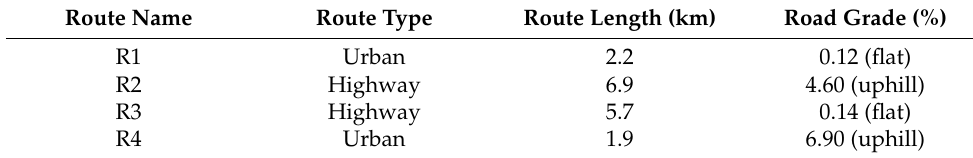
Table 3. Test routes’